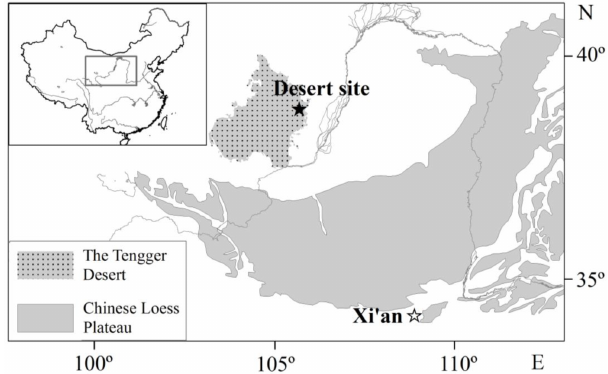
Figure 1. Location of the sampling sites. Also shown is the Chinese Loess